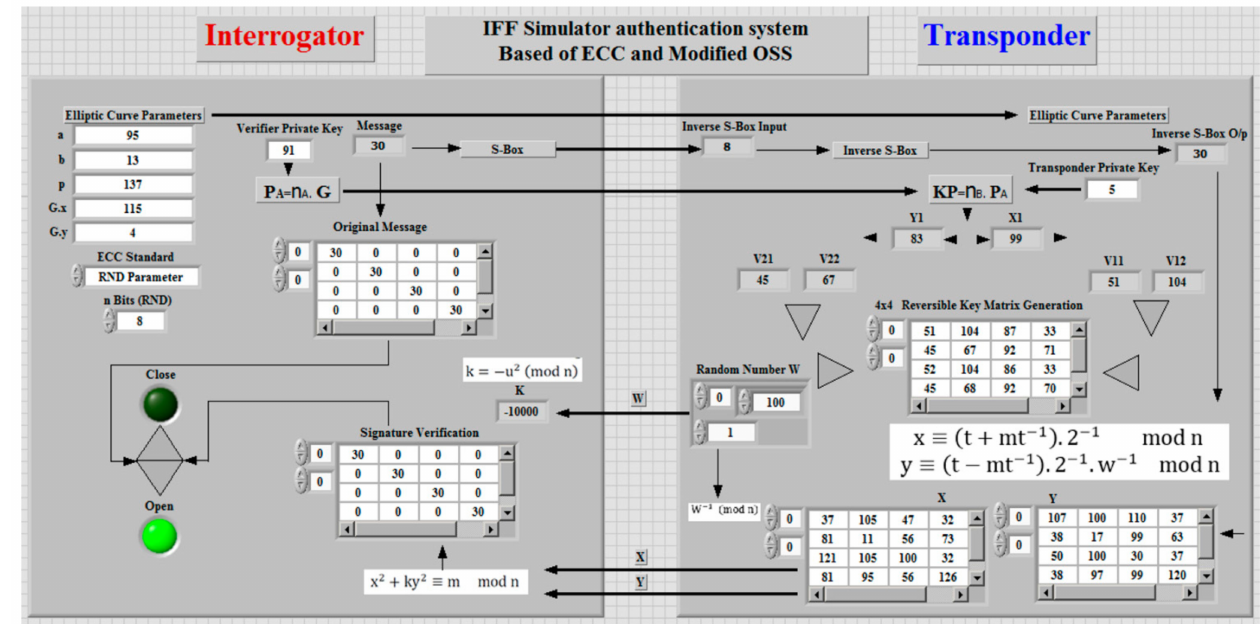
Figure 7. The proposed system layout implemented with